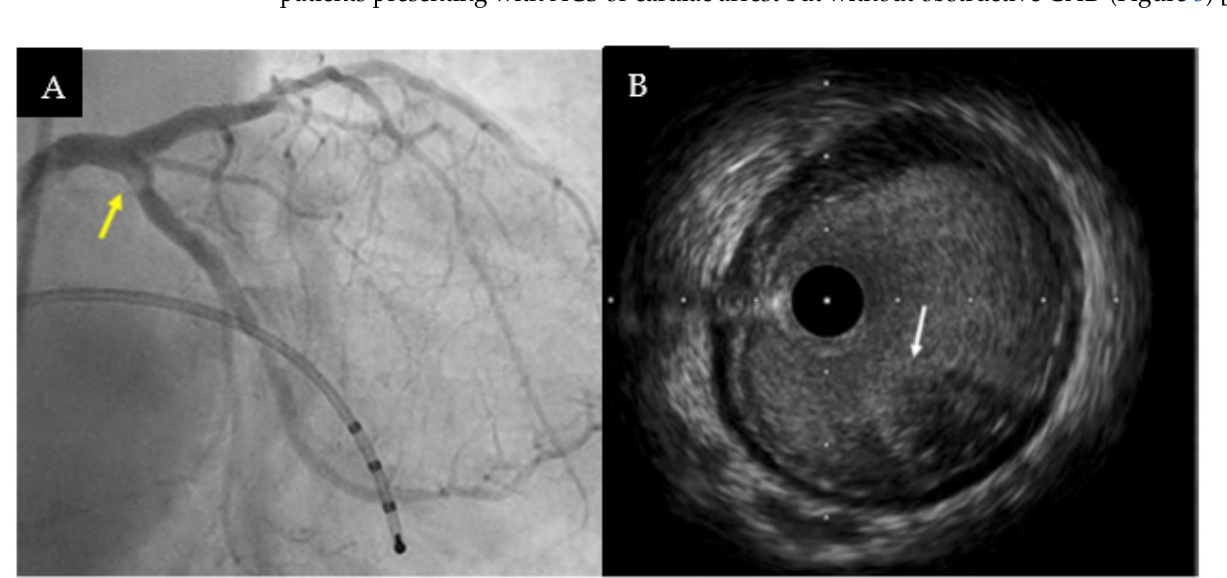
Figure 3. ( A ) Medical history suggesting a cardioembolic etiology for a patient admitted for inferior ST—segment elevation myocardial infarction with cardiac arrest on onset. Coronary angiography revealed haziness on ostial left circumflex artery (arrow). ( B ) IVUS highlighted intimal thickening with some backscattering to the lumen of the vessel, confirming the presence of intracoronary embolus without local atherosclerosis (arrow). The case was successfully managed with thrombus-aspiration and without stent implantation. Figures from authors’ library.